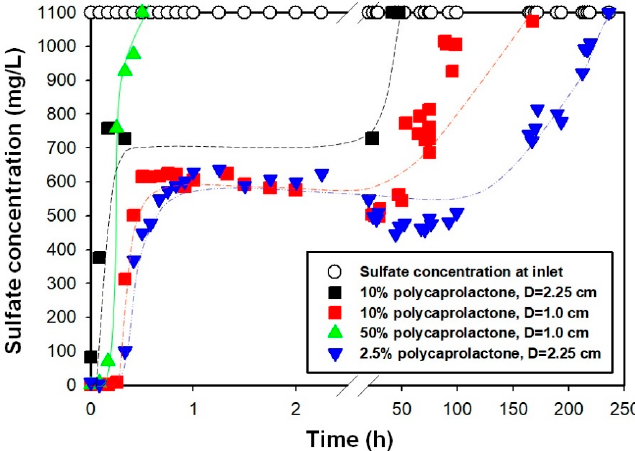
Figure 8. Comparison of remediation media for sulfate removal.